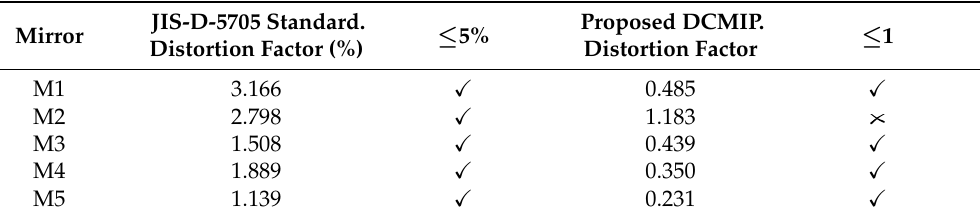
Table 1. Results of the distortion calculation of the mirrors using the JIS-D-5705 standard and the DCMIP.